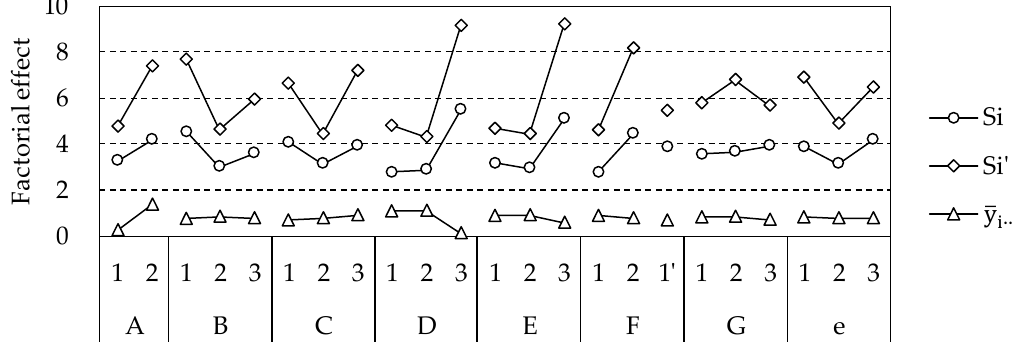
Figure 4. Factor–effect diagram of parameter-tuning factors Figure 4. Factor–e ff ect diagram of parameter-tuning